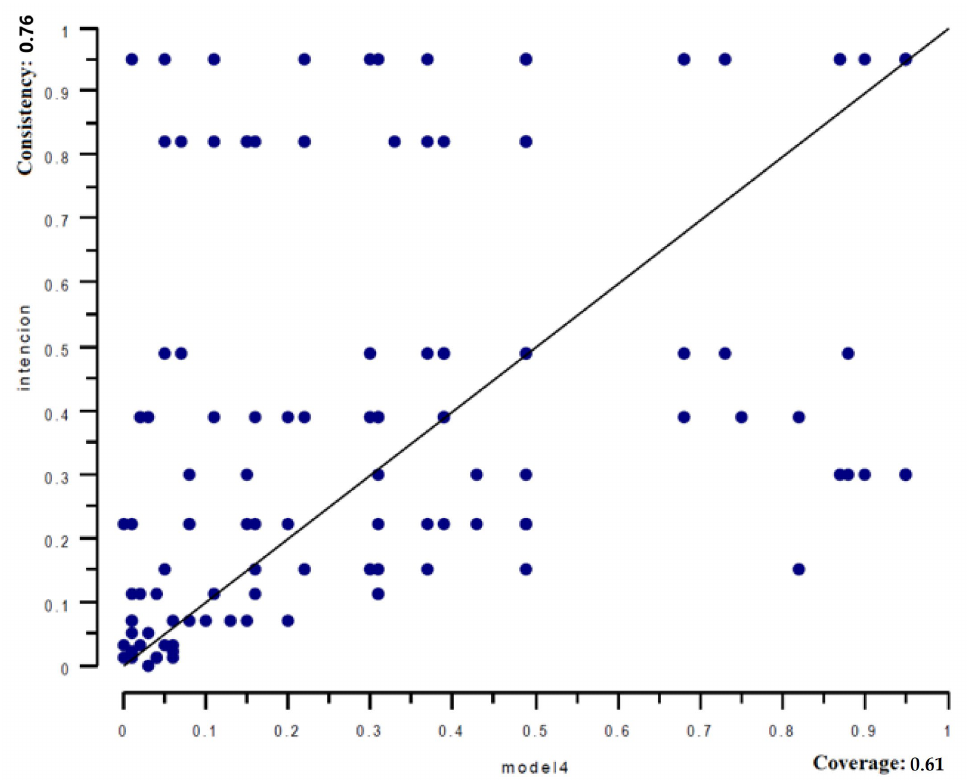
Figure 3. Test of Model 4 in sub-sample 1 using data from sub-sample 2.